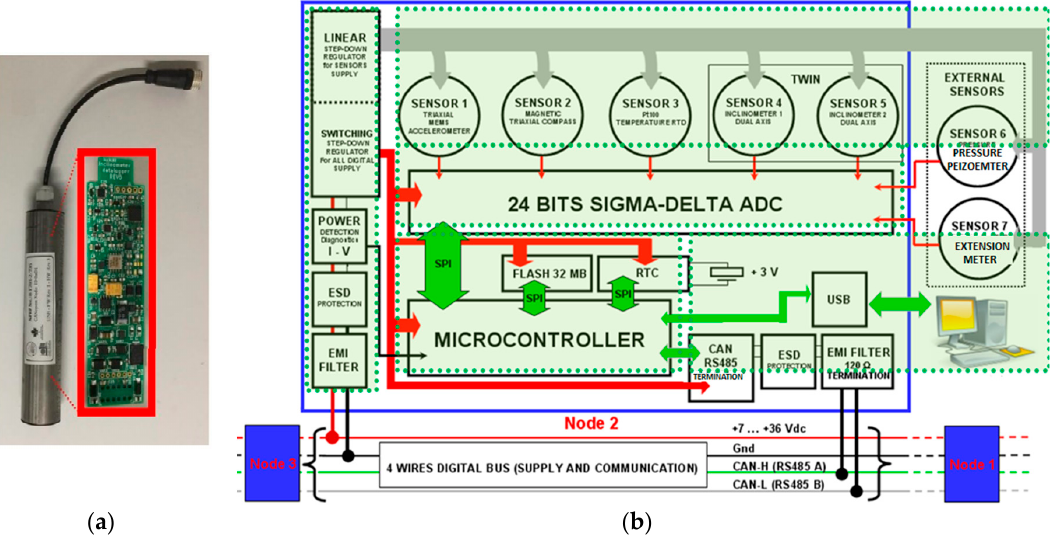
Figure 12. The C-SGBIN views as ( a ) C-SGBIN fabrication and ( b ) F-SGBIN architecture.